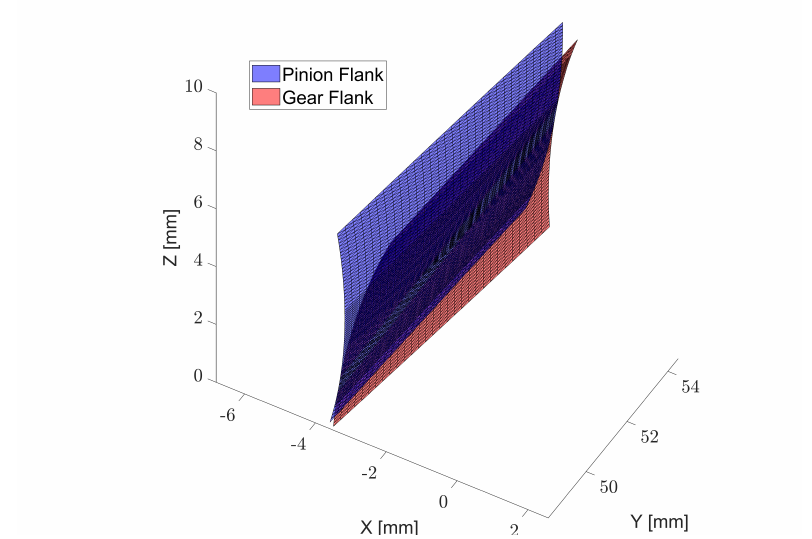
Figure 2. Triangulated tooth surfaces in initial rigid